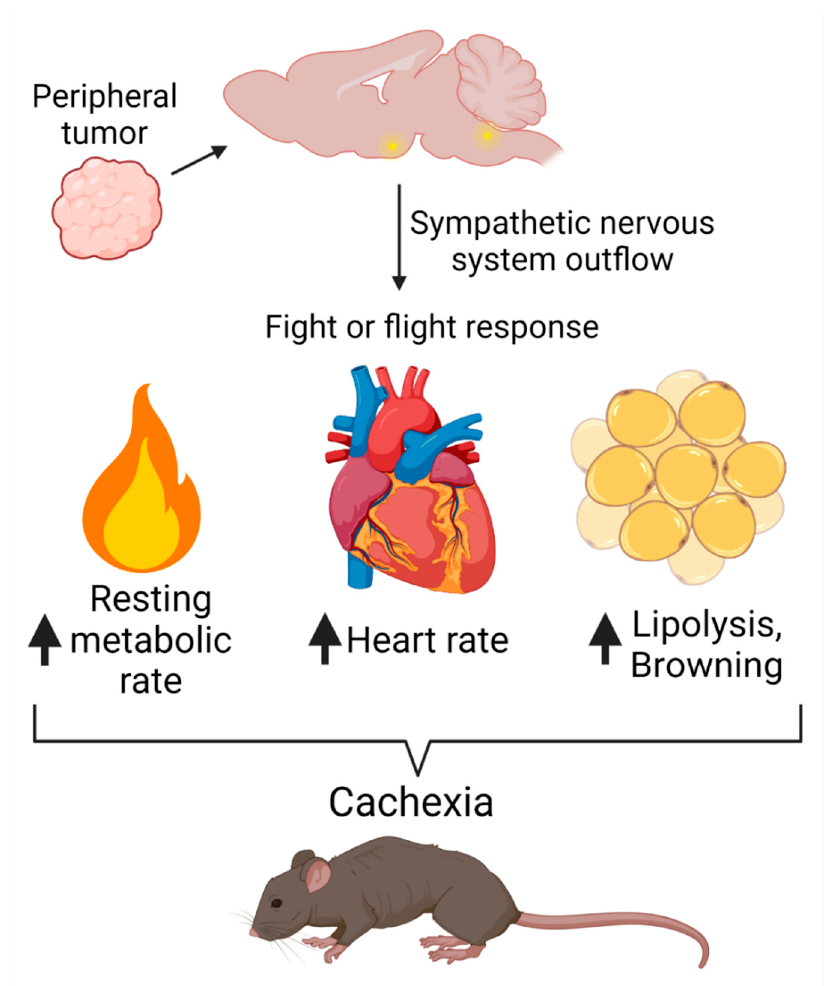
Figure 2. Model and potential mechanisms of sympathetic nervous system engagement in the pathogenesis of cancer.